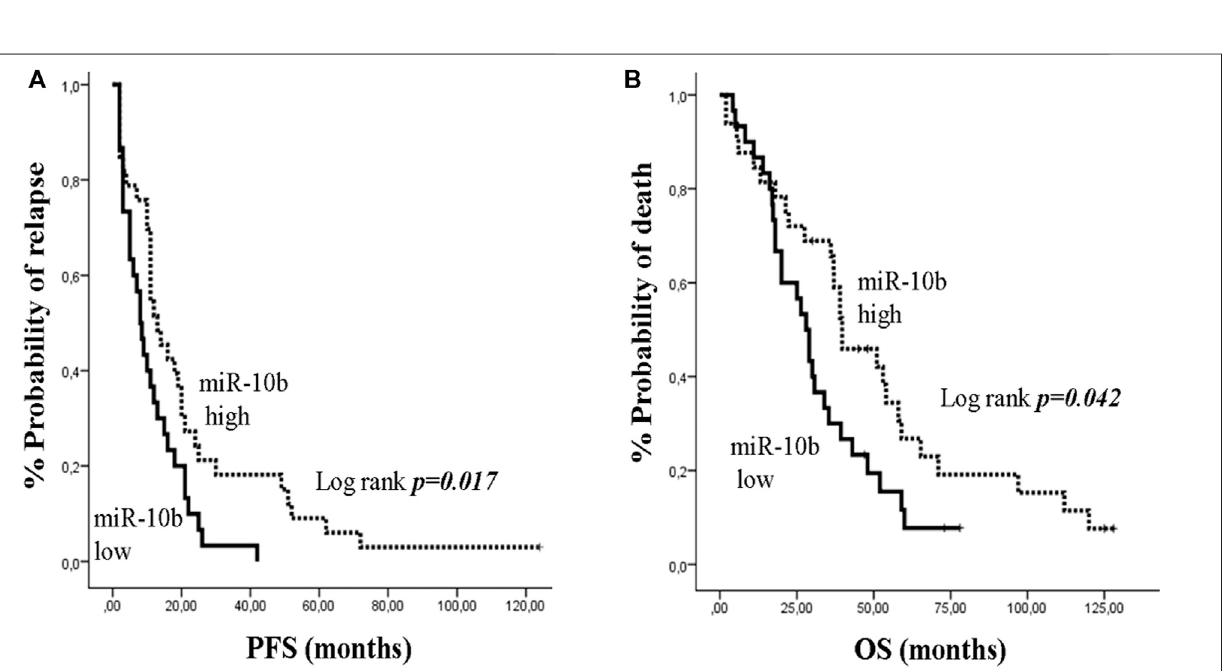
miR-126 (low vs high)